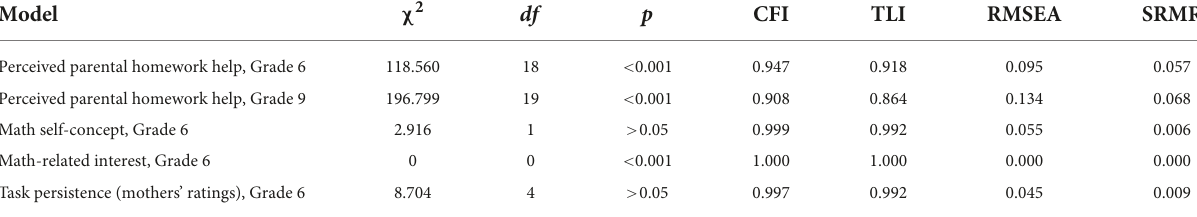
TABLE A2 Model fit indices of the confirmatory factor